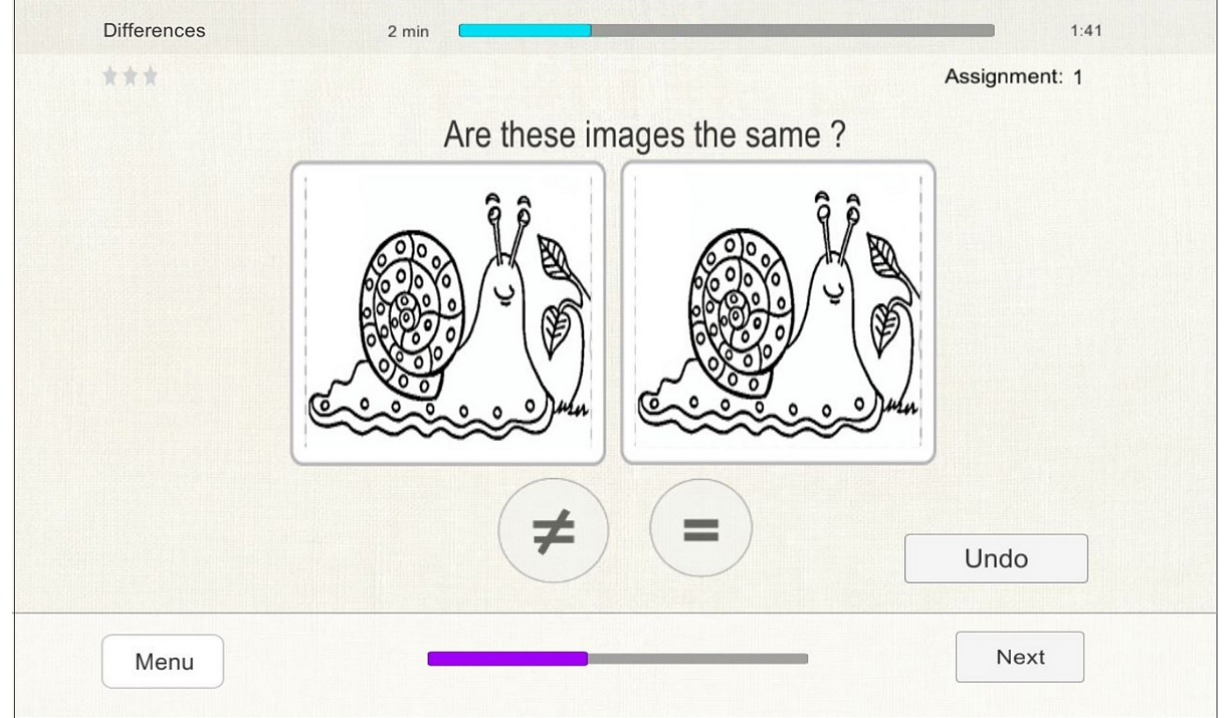
Figure 3. Differences exercise. Two pictures of the high difficulty level are matched.